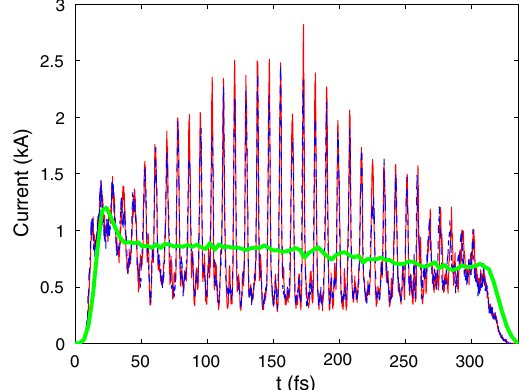
FIG. 7. Electron beam current before (green line) and after the chicane with (blue dashed line) and without (red solid line) the quantum diffusion and FEL interaction in the 8 undulators taken into account.